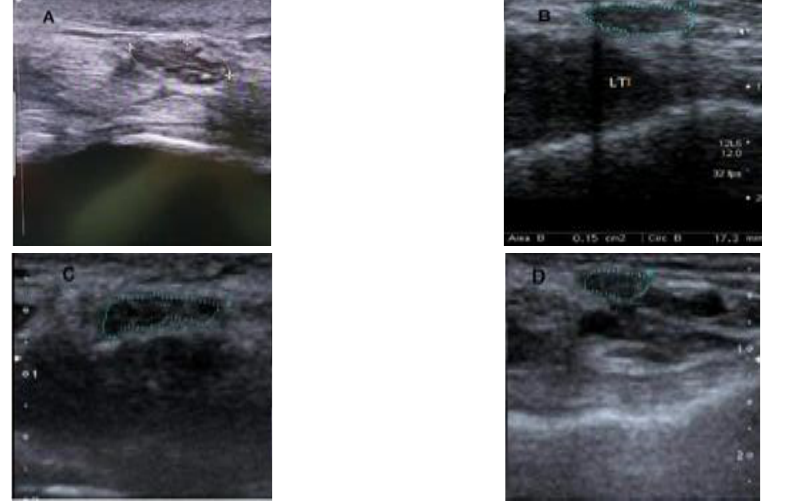
Figure 1. US examination of median nerve diameter (the dotted area) ( A ): pre-intervention, ( B ): at 1 month, ( C ): at 3 months, ( D ): at 6 months.